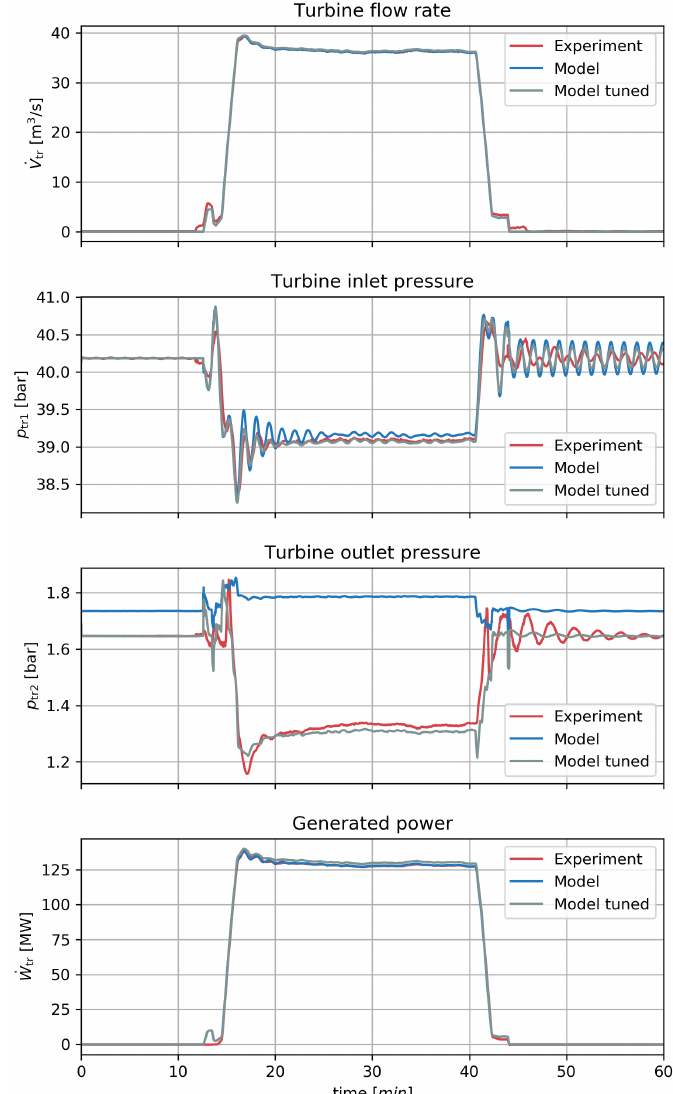
Figure 9. Comparison of the results from the tuned simple hydropower model (with tuned draft tube and roughness) and the experimental